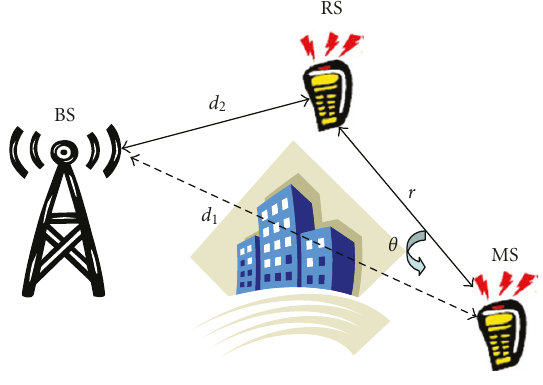
Figure 1: Opportunistic mobile relay.